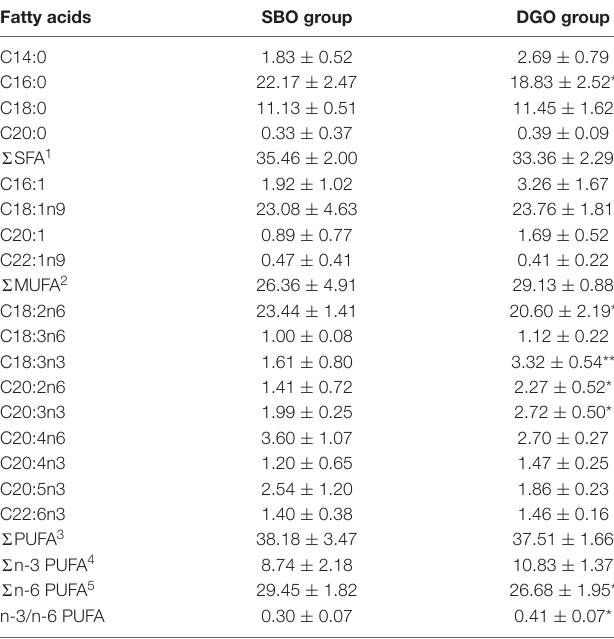
TABLE 6 | Effects of DAG-enriched oil on muscle fatty acid composition of fish. Fatty